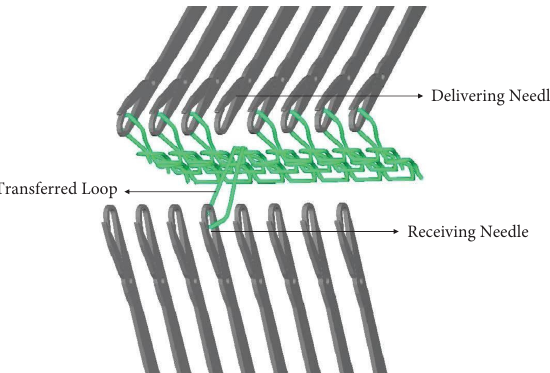
Figure 7: Animated view of transferred stitch using the apex III design system.